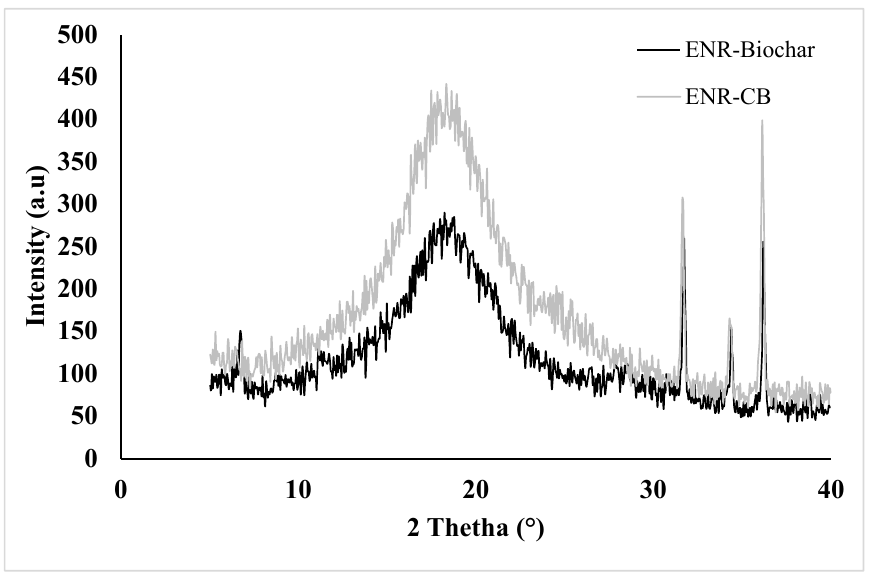
Figure 7. XRD patterns of ENR ‐ Biochar and ENR ‐ CB at 10 phr loading.